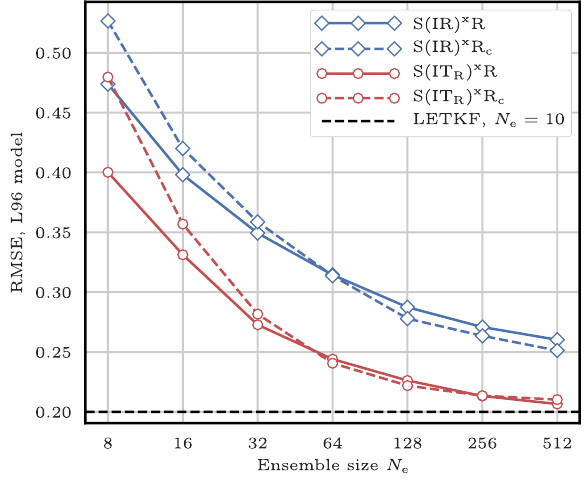
Figure 15. RMSE as a function of the ensemble size N e for the S(IR) x R, the S(IR) x R c , the S(IT s ) x R, and the S(IT s ) x R c algo-